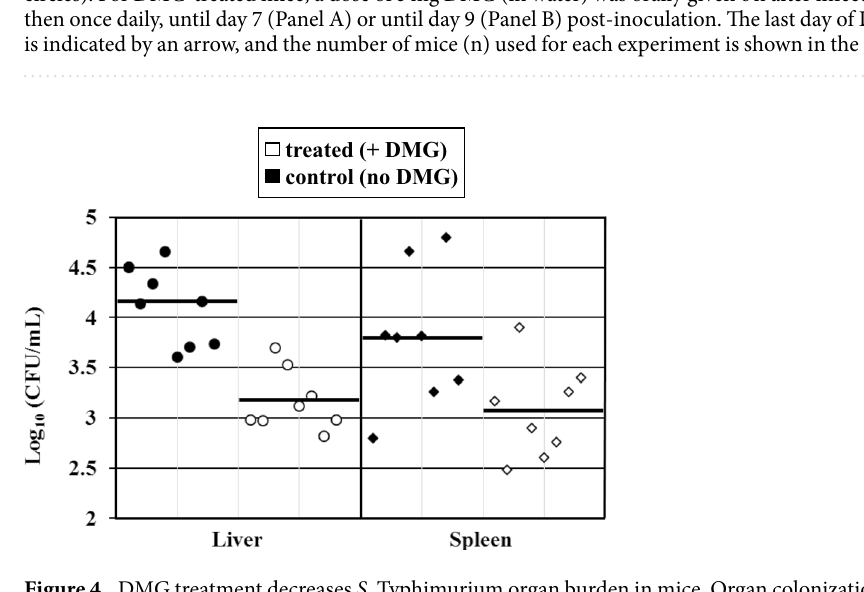
Figure 4. DMG treatment decreases S . Typhimurium organ burden in mice. Organ colonization of S . Typhimurium strain 14028 in the livers (circles) and spleens (diamonds) of infected mice (72 h post S .T. inoculation), after treatment with DMG (white symbols) or no DMG treatment (black symbols). Each symbol represents the mean (Log10) CFU/mL for one organ (liver or spleen, as indicated) and each horizontal bar represents the geometric mean of the colonization load for each group. The organ burden (mean colonization) in the DMG-treated group is significantly lower compared to the control group (no DMG), P < 0.01 for livers and P < 0.025 for spleens,